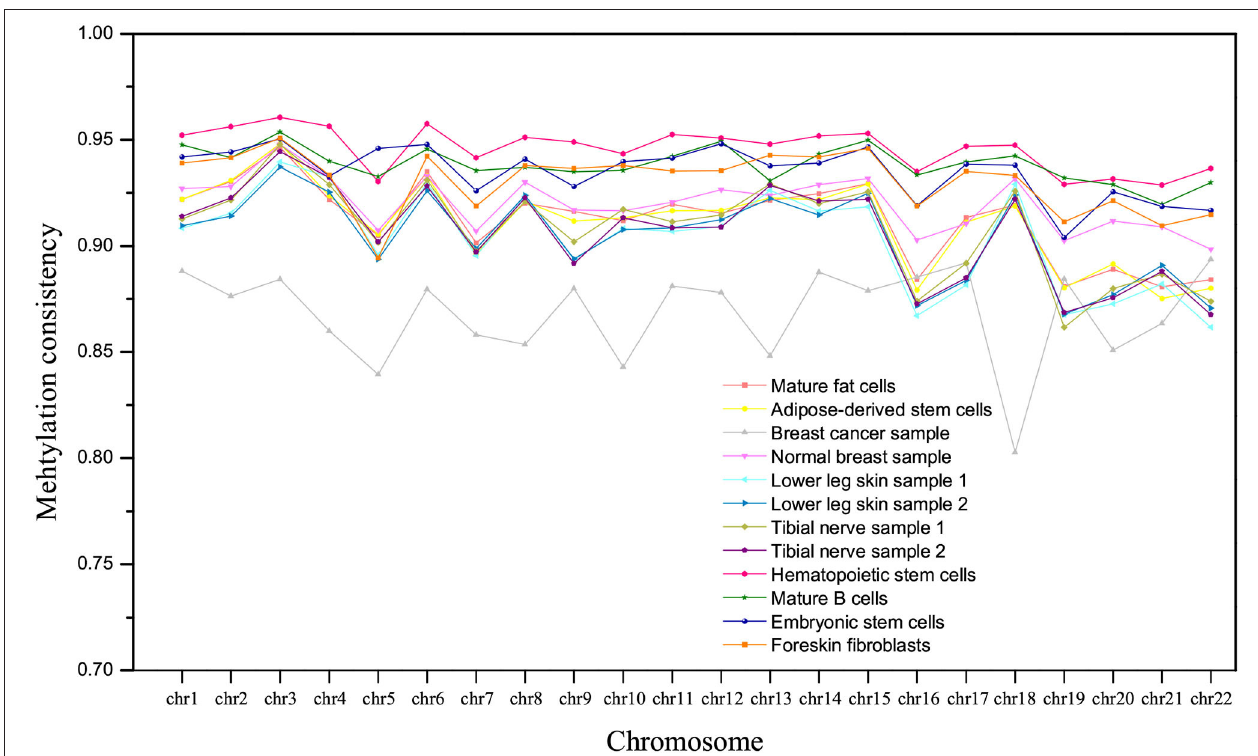
FIGURE 3 | The comparison of methylation consistency of homologous chromosomes in different tissues/cell types.